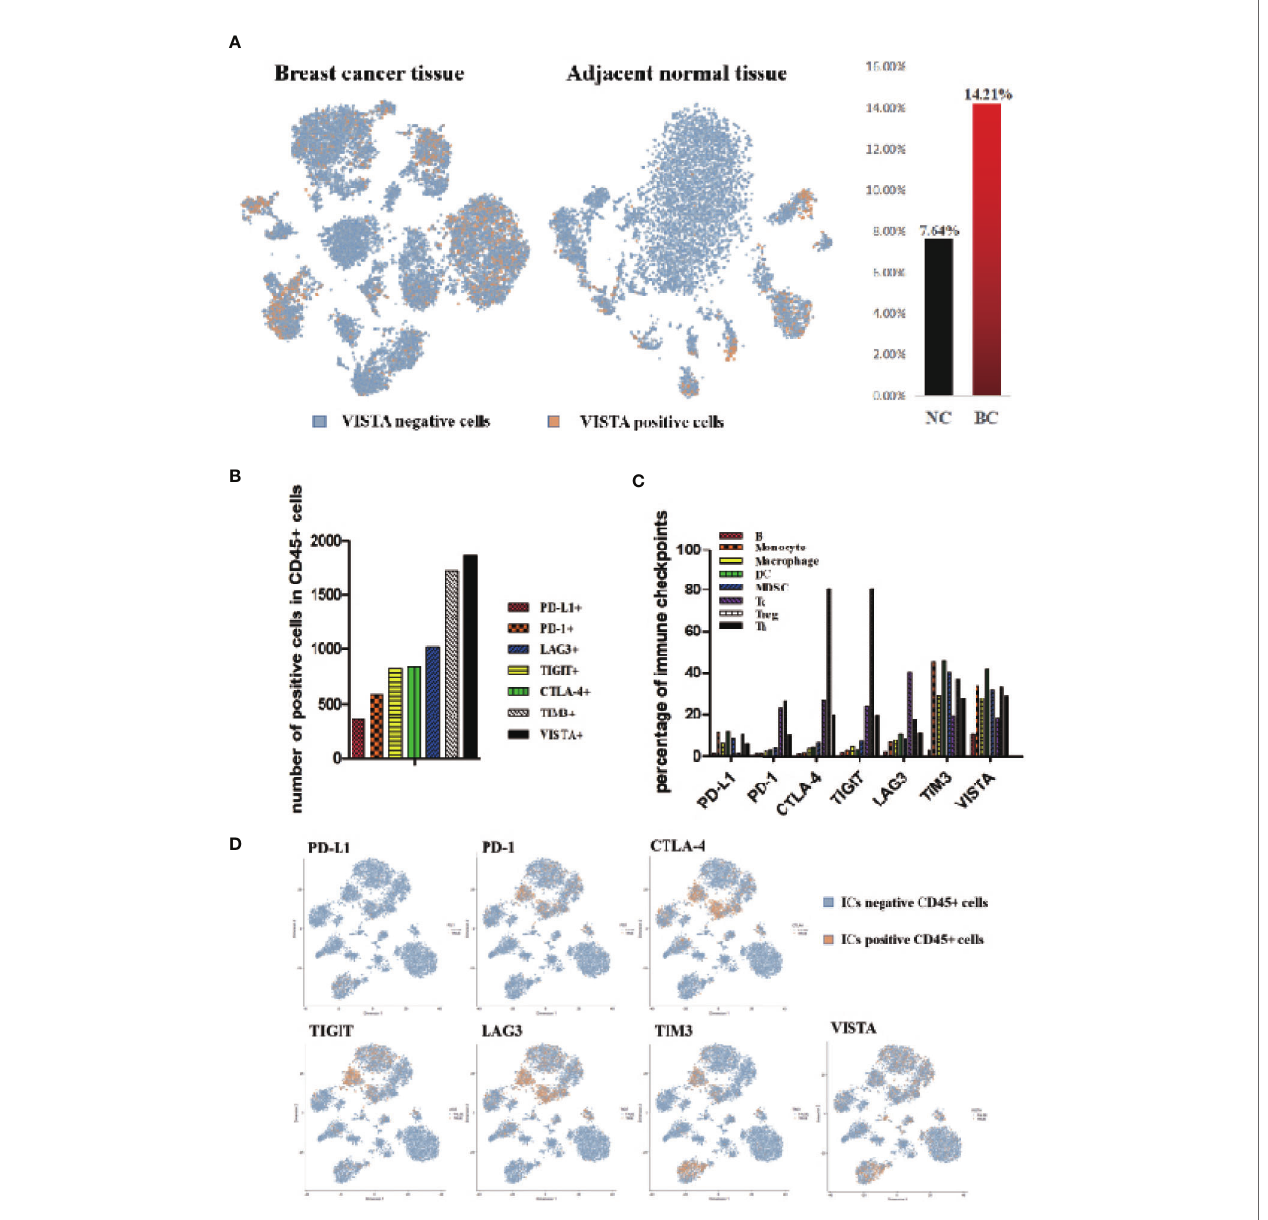
FIGURE 2 | Immune Checkpoints expressions heterogeneity in immune cell populations in the breast cancer tissue. (A) t-SNE of normalized single-cell RNA-seq data for VISTA colored by markers. VISTA positive cells (orange), VISTA negative (blue). (B) Histogram of the expression of each immune checkpoint (PD-L1, PD-1, CTLA-4, TIGIT, LAG3, TIM3 and VISTA) in the microenvironment of breast cancer tissue. (C) Histogram of percentage of each immune checkpoint (PD-L1, PD-1, CTLA-4, TIGIT, LAG3, TIM3 and VISTA) in the primary immune cell subpopulation in the breast cancer microenvironment. (D) t-SNE of normalized single-cell RNA- seq data for ICs (immune checkpoints) colored by markers. ICs positive cells (orange), ICs negative